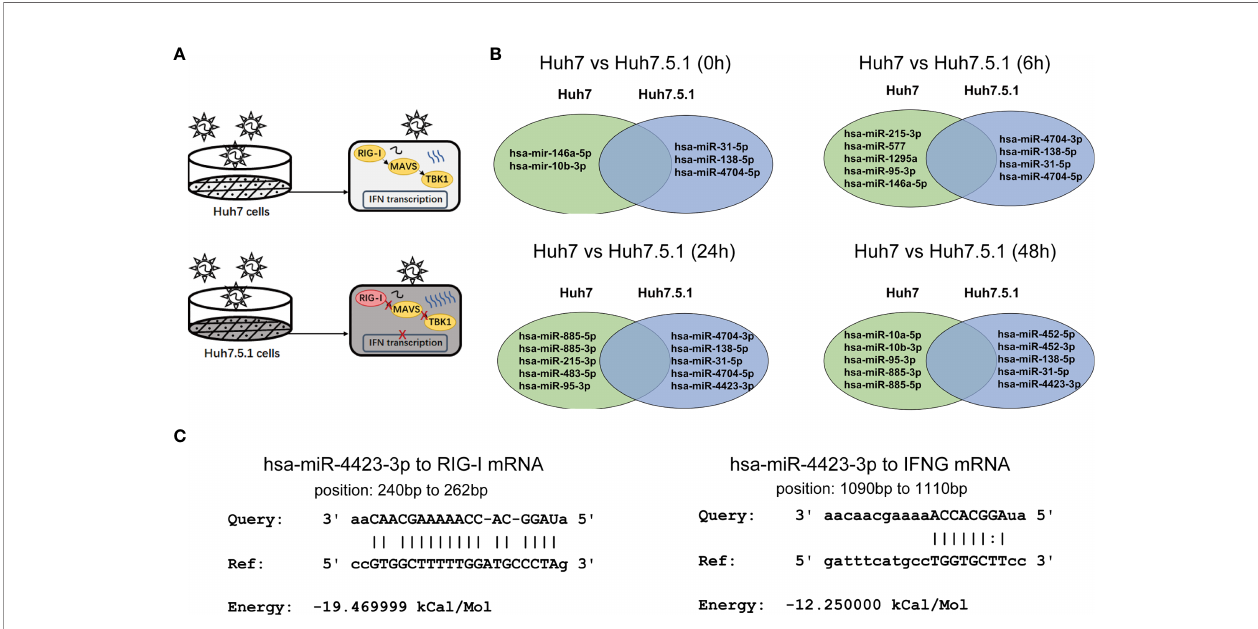
FIGURE 4 | Candidate miRNA concerning IFN production pathway was selected from the differentially expressed miRNAs. (A) Diagram depicted the different responses between Huh7 and Huh7.5.1 cells after HCV infection. (B) MiRNAs with different change trends in the two cell lines, and the differentially expressed miRNAs were shown at respective infected periods (0, 6, 24, and 48 h). (C) Potential targets of miR-4423-3p were predicted and their interactions were illustrated. Results were shown as relative mRNA expression